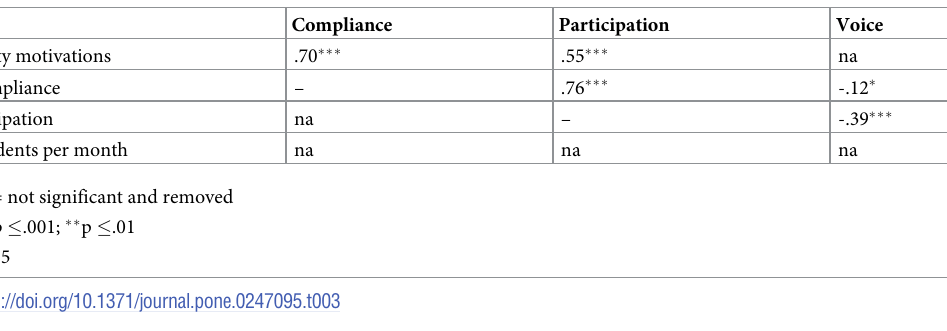
Table 3. Relationships between exogenous